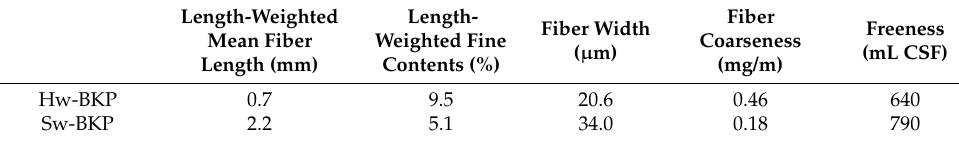
Table 1. Fiber properties of raw